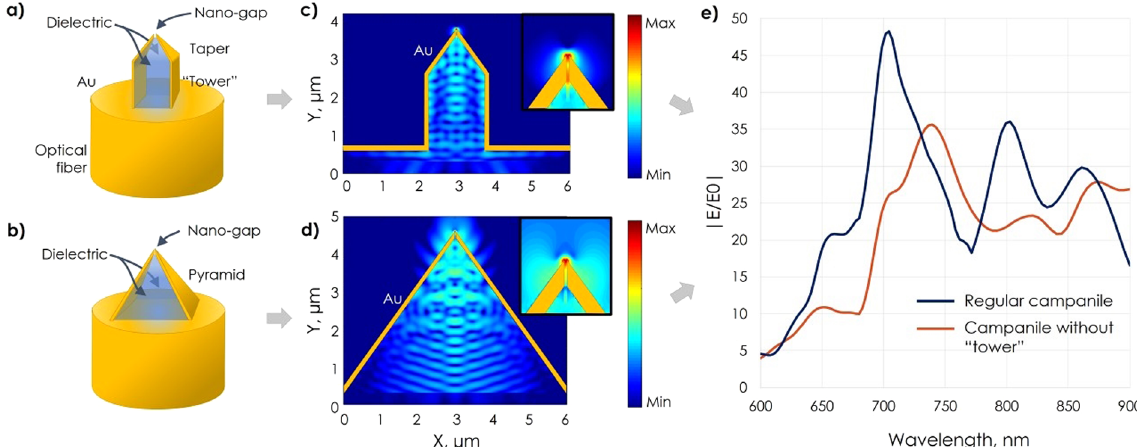
Figure 1. Campanile probe geometry and simulations. Geometries of the regular ( a ) and “tower-less” campanile probe ( b ). The main difference is that the latter lacks a columnar tower between the pyramid structure and optical fiber and has a larger base. FDTD simulations of the electric field amplitude inside the campanile for a regular ( c ) and “tower-less” ( d ) campanile. The insets show close-up views of the hot-spot on the apex. The horizontal extent of the inset is 600 nm, and the width of the campanile gap is 20 nm. Comparison of field enhancements as a function of wavelength for both configurations ( e